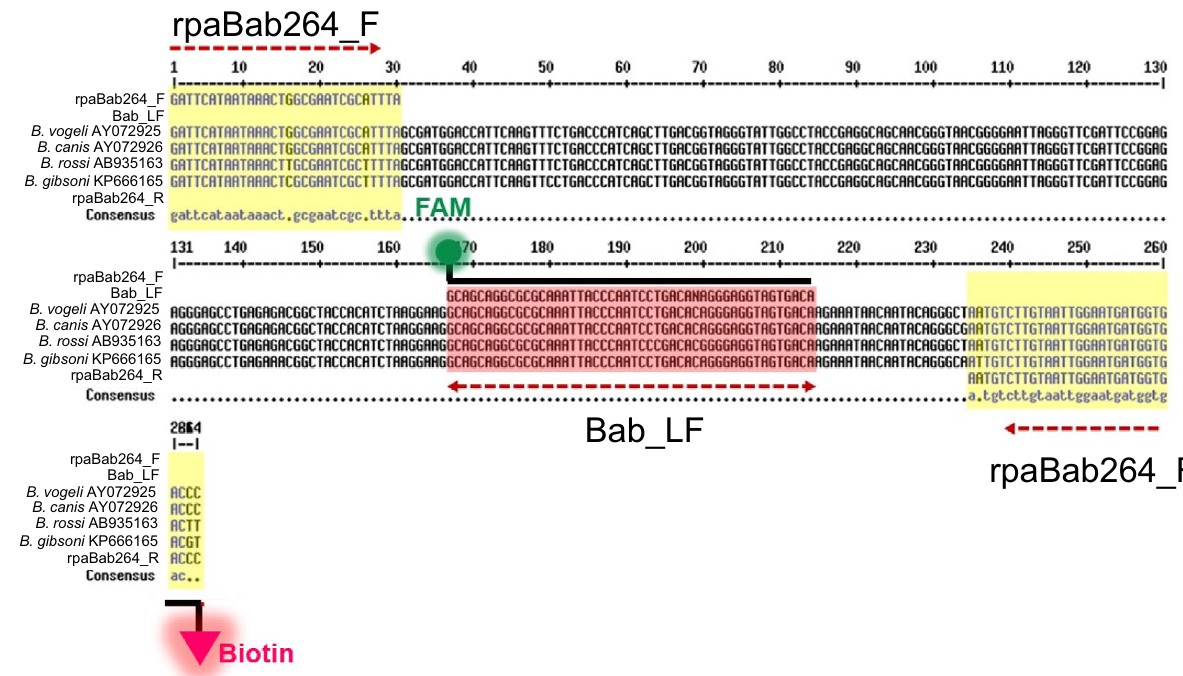
Figure 1. DNA binding sites of rpaBab264 and Bab_LF for Babesia spp. detection by nfo RPA assay. Partial 18S rRNA sequences from different species of Babesia retrieved from GenBank were aligned by